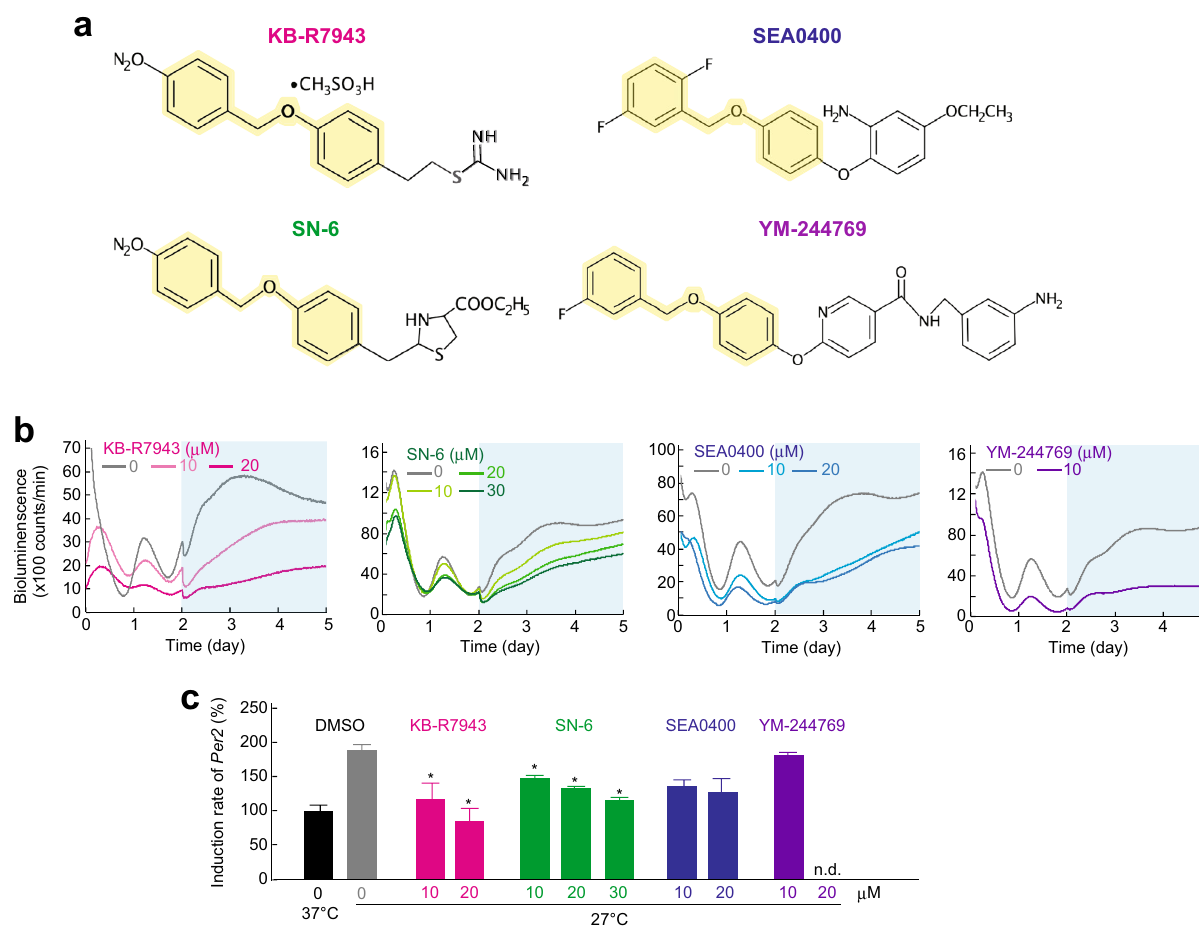
Figure 4. Effects of NCX inhibitors on cold Per2 induction. ( a ) Structures of NCX inhibitors, KB-R7943, SN-6, SEA0400, and YM-244769. Yellow background shows a common structure of the four inhibitors. ( b ) Effects of NCX inhibitors on cold induction of Per2 -luc reporter. ( c ) Effects of NCX inhibitors on induction rate of Per2 - luc reporter. The induction rate was calculated by dividing the AUC during Term II (27 °C) by the AUC during day 1 to 2 (control, 37 °C) (marked as example in Fig. 3a). Because 20 µM YM-244769 showed cell toxicity, the data of that was not determined (n.d.). The means of induction rate of DMSO control group at 37 °C was set to 100 in vertical axis. Mean with s.e.m. from 4 independent samples are shown. * p < 0.05 compared to the DMSO control at 27 °C (Dunnett’s